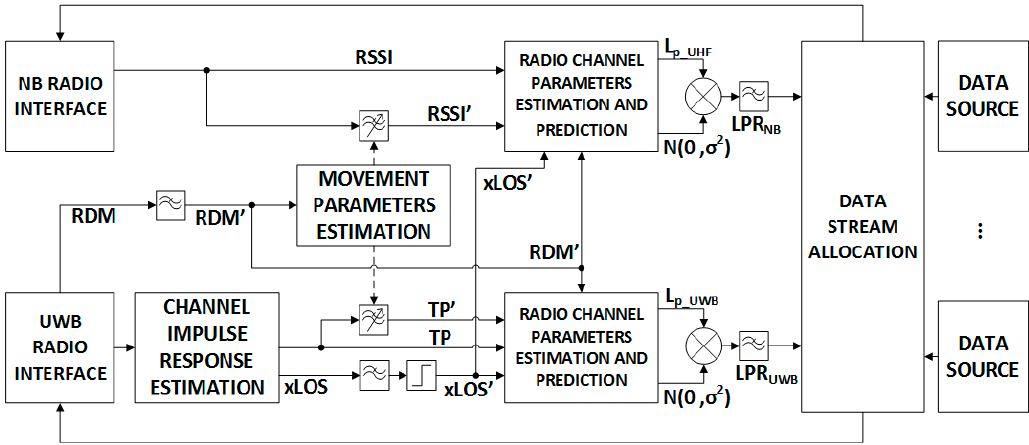
Figure 2. Block diagram of the proposed developed novel adaptive method for data stream allocation (AMASD).